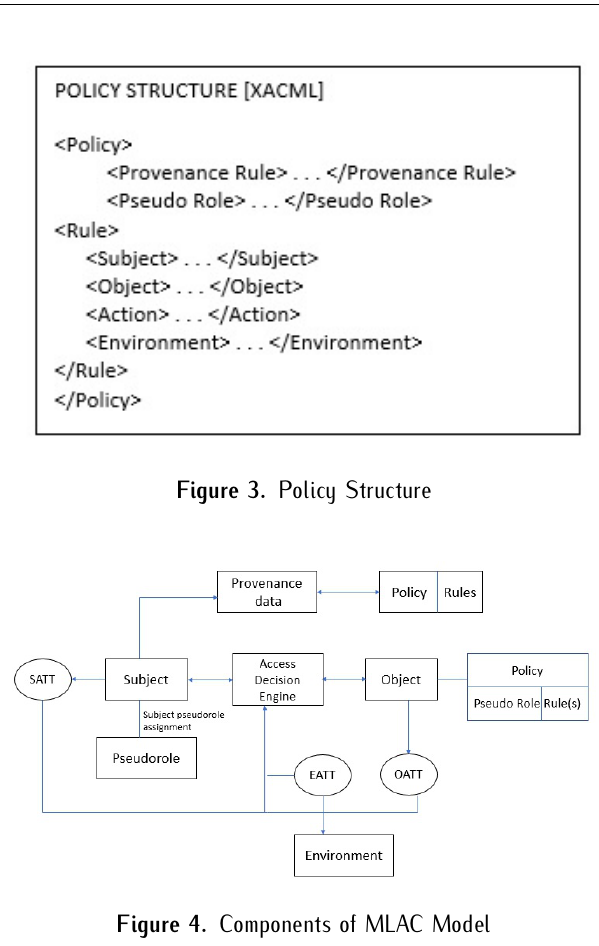
Figure 4. Components of MLAC